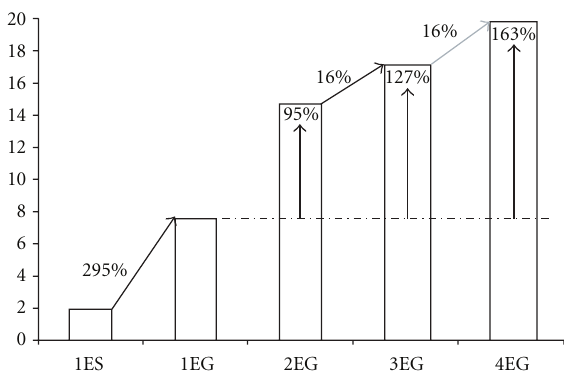
Figure 2: Genetic gains in 2.5-year-old family mean stem volume (dm 3 ) for 27 1st-generation E. saligna (1ES), 117 1st-, 211 2nd-, 126 3rd-, and 48 4th-generation E. grandis (1EG, 2EG, 3EG, and 4EG, resp.) families in genetic base population GP77.